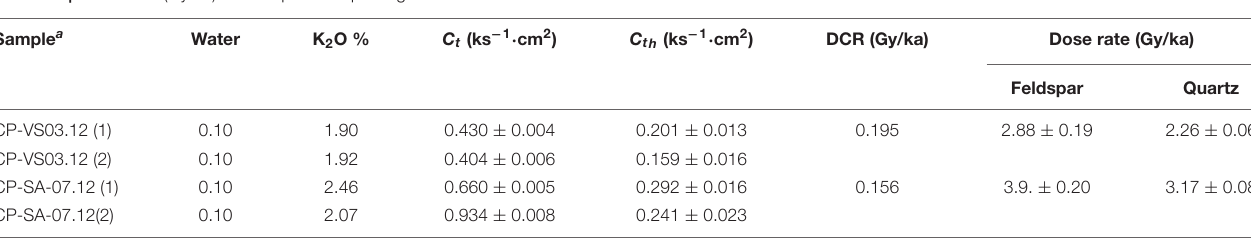
FIGURE 3 | Google image showing main landform of the BRB: bare ice glaciers; debris-covered glaciers, rock glaciers, moraines, and outwash deposits. The 10 Be ages of the Salto outwash and moraines of Angostura and Mulas rivers are in yellow letters (after Moreiras et al., 2017). Note that the Angostura valley has preserved relict moraines at the headwaters but uncovered glacier in the highest peak of the Plata peak (5,956 m asl) is missed. RBF, Rio Blanco fault and SF, Salto fault mapped in red lines. Number indicates places where the rock avalanche outcrops. TABLE 1 | Dose rates (Gy/ka) for feldspar and quartz